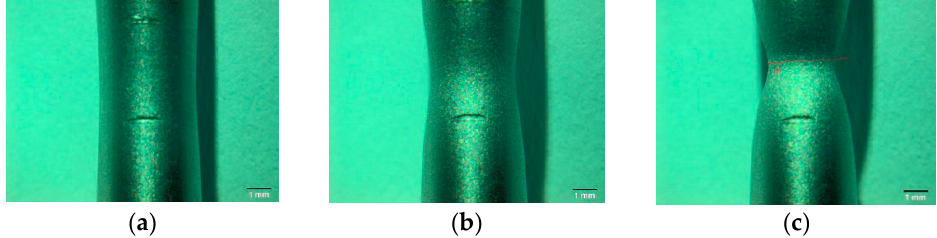
Figure 7. Examples of forming neck during specimen tensile (recorded by video-camera Olympus): ( a ) ~250 sec, start of necking; ( b ) ~350 sec; and ( c ) ~450 sec, before specimen fracture.